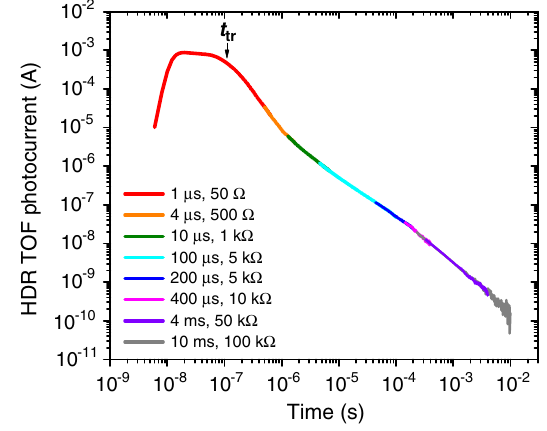
FIG. 17. An example of HDR TOF photocurrent transients. It is reconstructed by overlaying a set of transient sections captured with successively incremented sensing resistances (see legend for details). The device under test (DUT), a glassy TOF device of about 1 . 8 μ m made from HMW PFO, was probed at room temperature under 10-V external bias and with a fixed laser excitation intensity (such that Q=Q 0 ≈ 15 %). Pre- and post- transit regimes of the HDR transient are distinguished by an arrow denoting the carrier transit time ( t tr